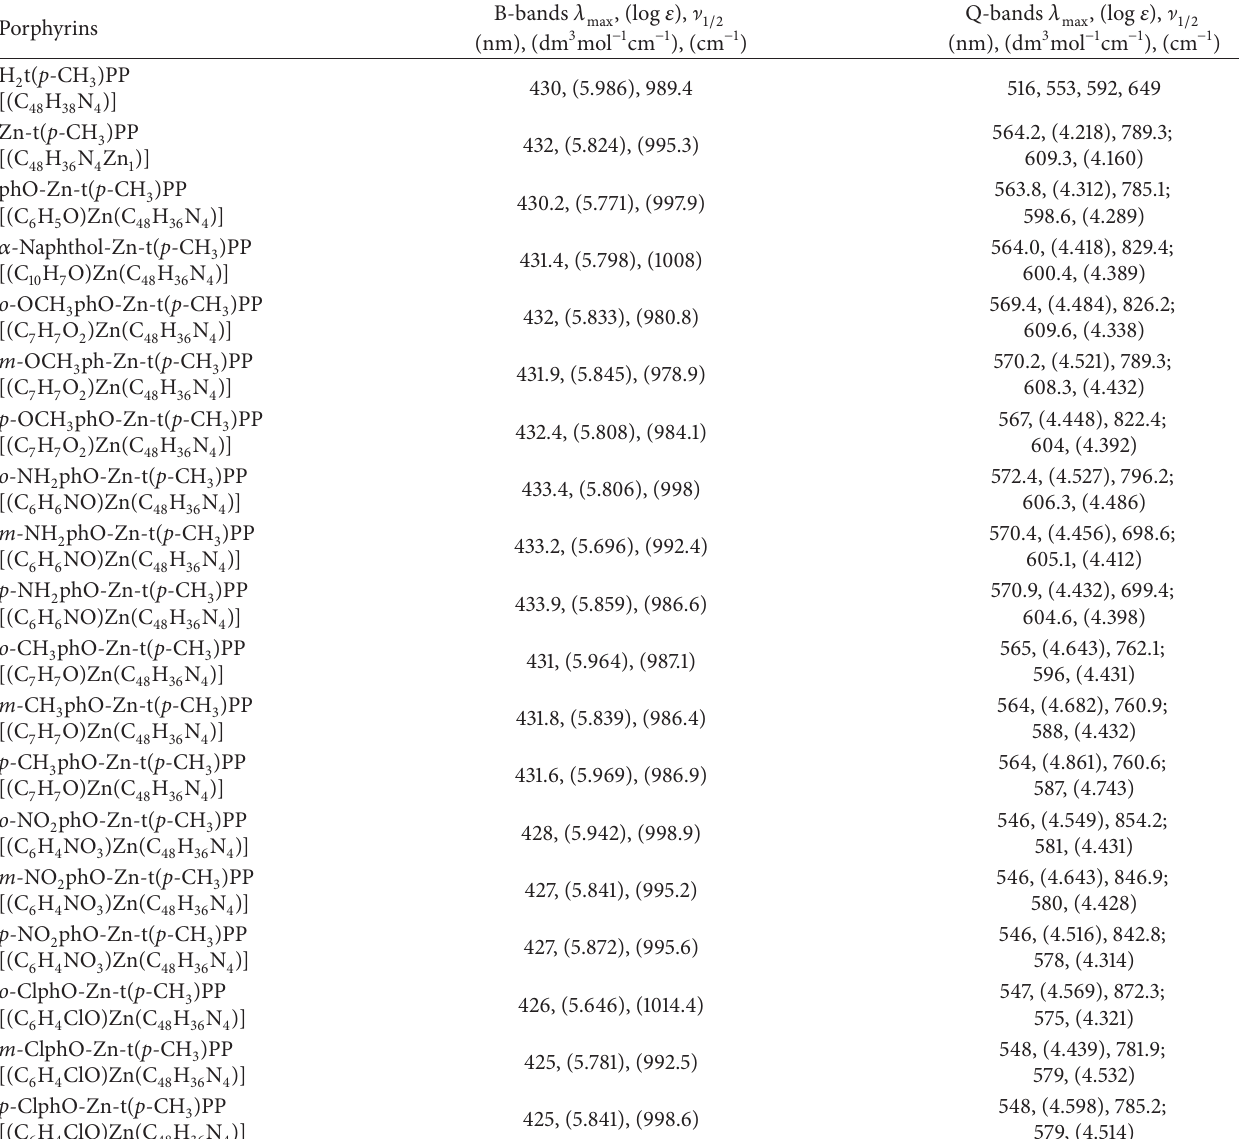
Table 2: Optical absorption data of X-Zn-t( p -CH ] 1/2